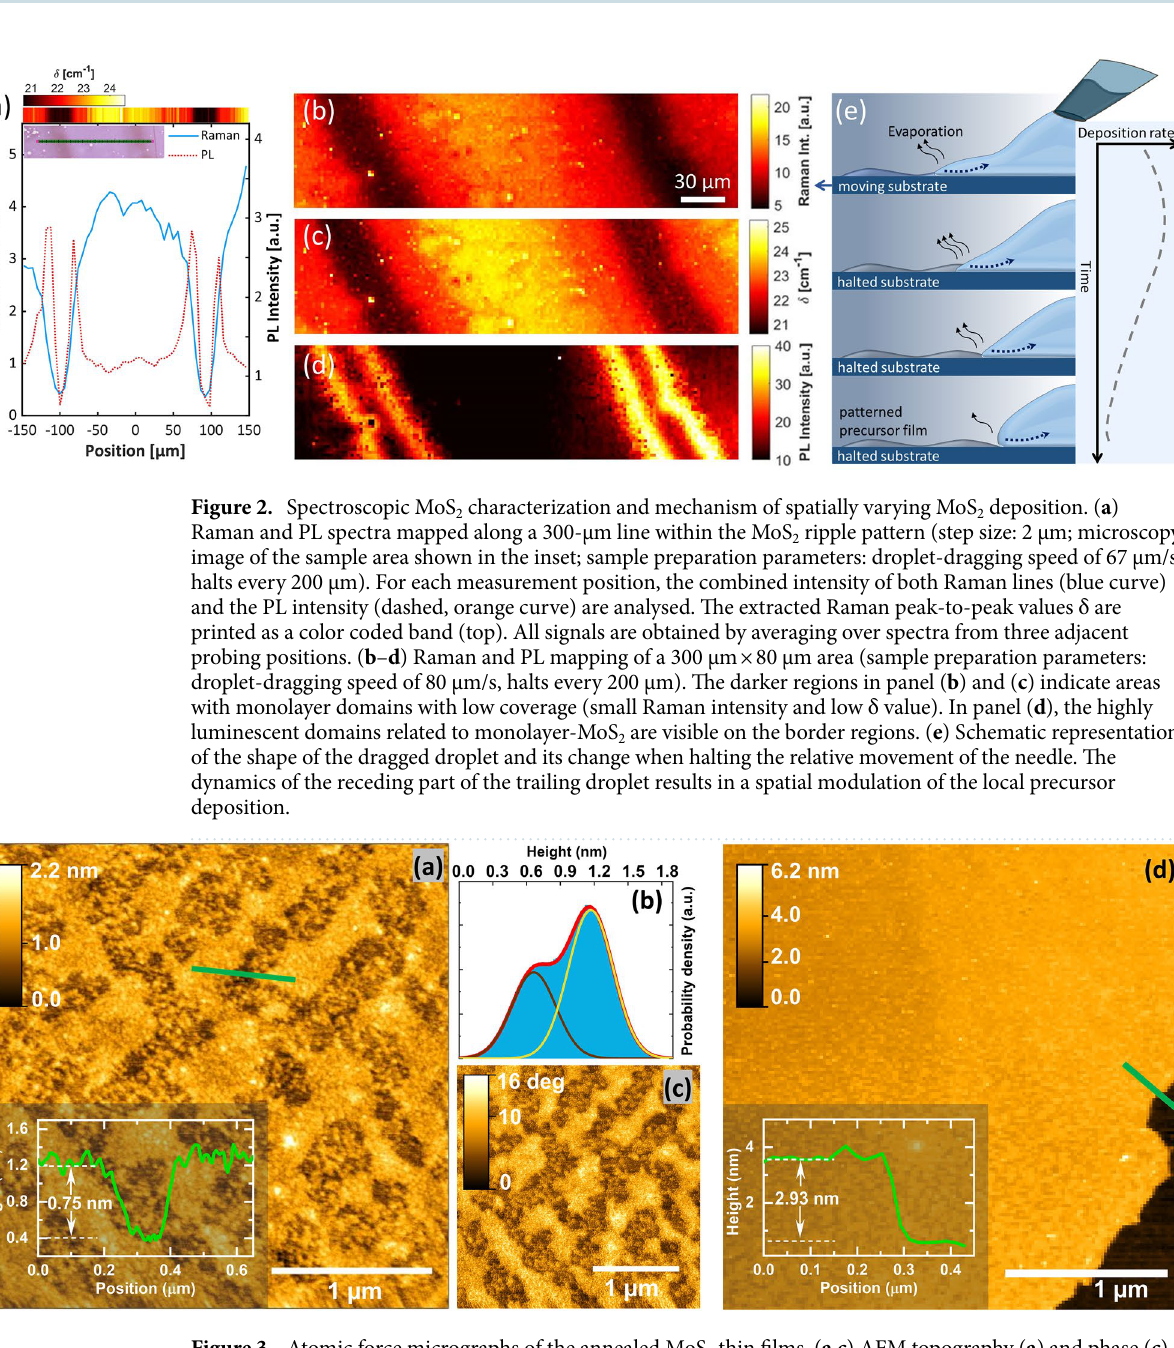
Figure 3. Atomic force micrographs of the annealed MoS 2 thin films. ( a , c ) AFM topography ( a ) and phase ( c ) micrographs of an optically dark region of the sample shown in Fig. 1b. ( b ) Height distribution extracted from the image shown in ( a ). ( d ) Topographic AFM micrograph recorded at the centre of an optically bright region. Insets: Exemplary height cross-section transversely averaged over about 45 For further quantification of the changing optical properties across the ripple pattern, we performed Raman and PL line scans (300-µm scanning length, 2-µm step size, optical focal spot size about 1 µm, Fig. 2a) and area mappings (300 × 80 µm 2 , 2-µm step size, Fig. 2b–d) and analysed at each point the overall PL intensity as well as the Raman intensity and peak position. Nonzero Raman and PL intensity across the whole pattern (Fig. 2b,d) indicates the presence of MoS 2 material at each probing position. The large PL intensity observed in the border region coincides with Raman peak spacings of about 20 cm −1 (Fig. 2a top colour scale, Fig. 2c), signifying the formation of a MoS 2 mono-/bilayer with high surface coverage. In the adjacent dark region, a similar Raman peak spacing and PL spectral shape as in the border region but with reduced PL and Raman intensity points to a mono-/bilayer film with low surface coverage. We note that depending on the overall amount of deposited material, for some samples we observed a gradual increase of PL towards the centre of the dark region (see Sup- plementary Information Fig. S1), indicating that in these cases a monolayer with uniformly high surface coverage was formed throughout this region.